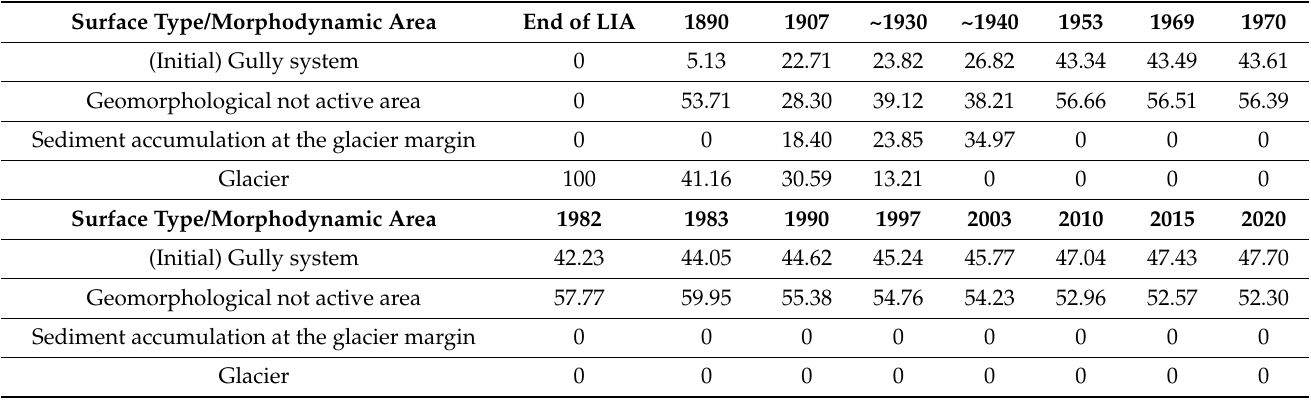
Table A6. Changes of surface types/morphodynamic area from End of LIA to 2020 with the proportion